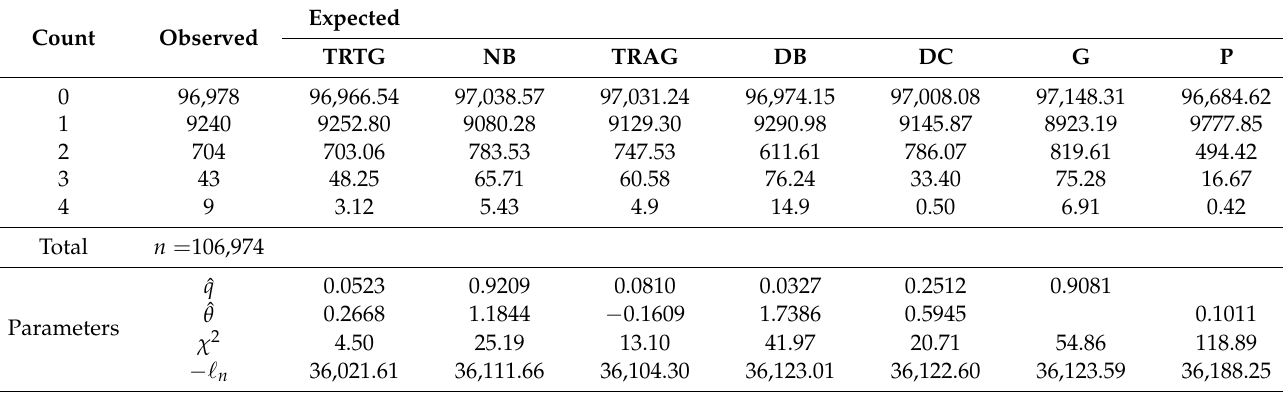
Figure 3. Observed and fitted distributions for first data. Table 6. Results of observed and expected frequencies, χ 2 and − (cid:96) n , respectively, for second